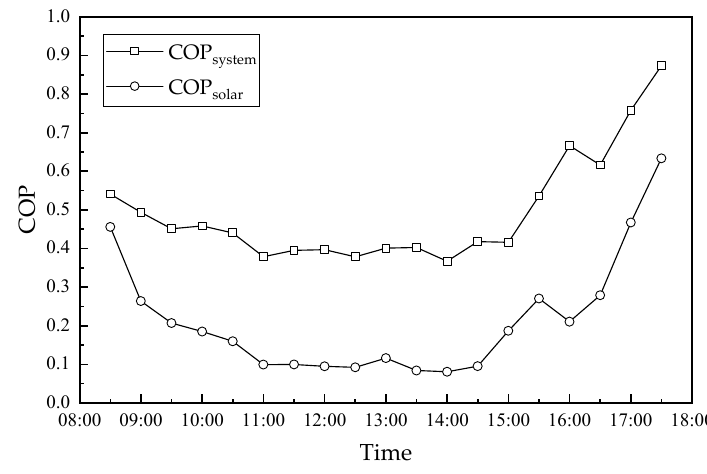
Figure 14. Hourly variation in the COP system and COP solar .